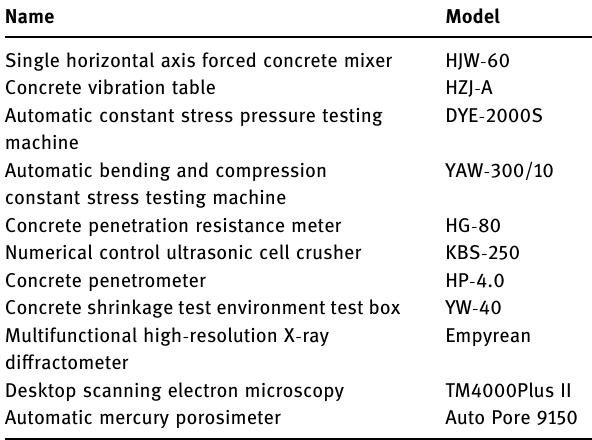
Table 8: Laboratory apparatus